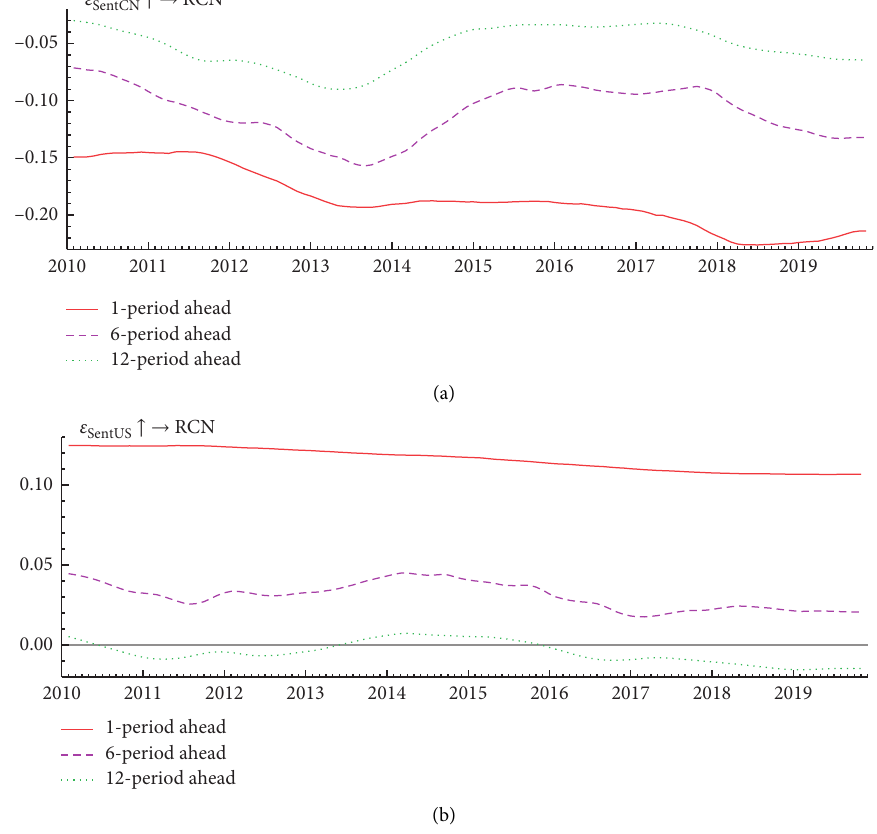
Figure 6: Time-varying impulse responses of China stock market return.